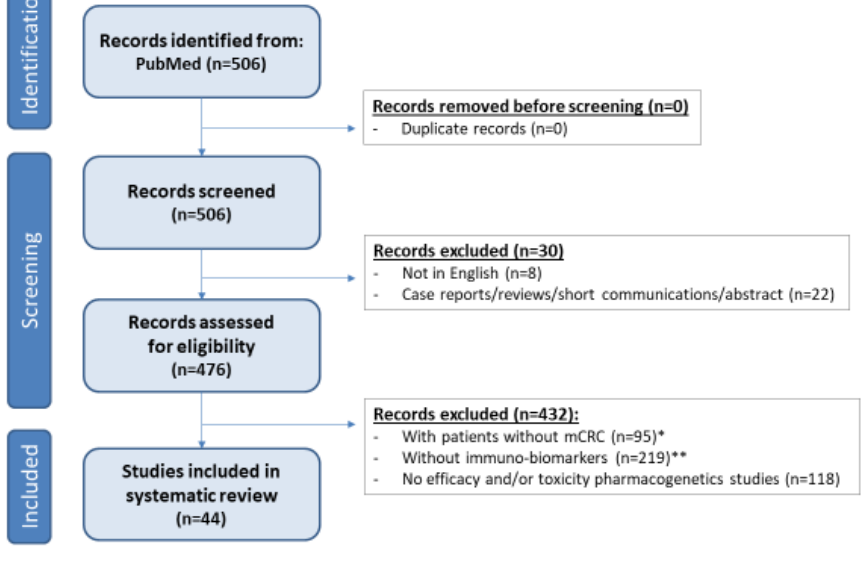
Figure 2. Studies selection flow diagram.